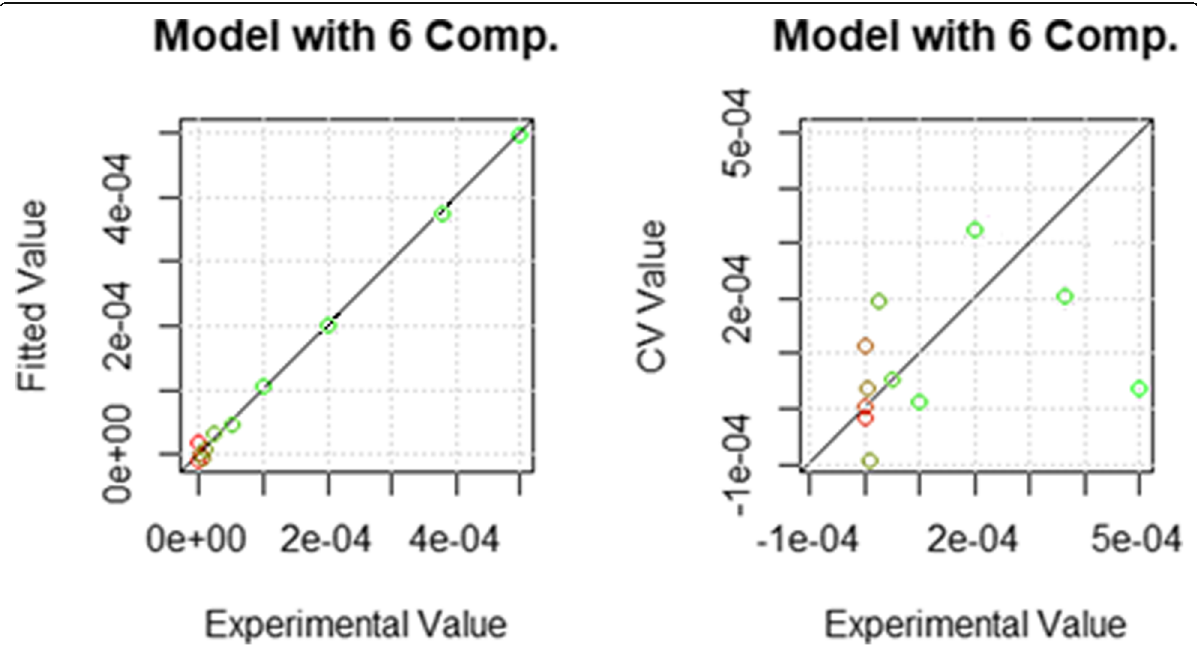
Fig. 4 Software output for the PLS regression model, based on 6 latent variables, for the Mg(II) determination by EBT-CC sensor. The different colours refer to two different experiments at low (red) and at high (green) metal ion concentration. (1) Comparison of the experimental points with the points recalculated from the model; (2) the same comparison but in conditions of cross-validation. This plot assesses the variability of the estimated parameters and its effect on the prediction